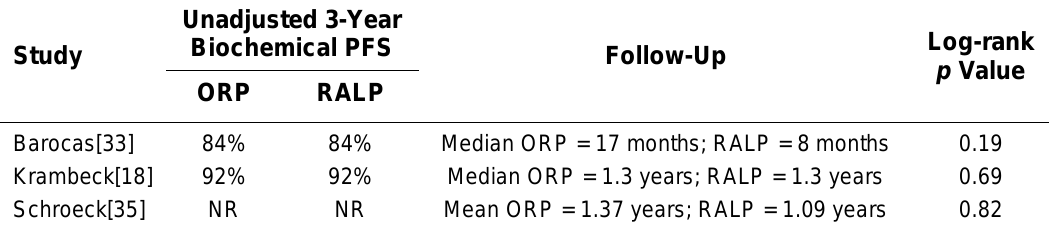
Oncologic Outcomes in Comparative Studies of ORP vs RALP: Biochemical PFS Rates Unadjusted 3-Year Biochemical PFS Study